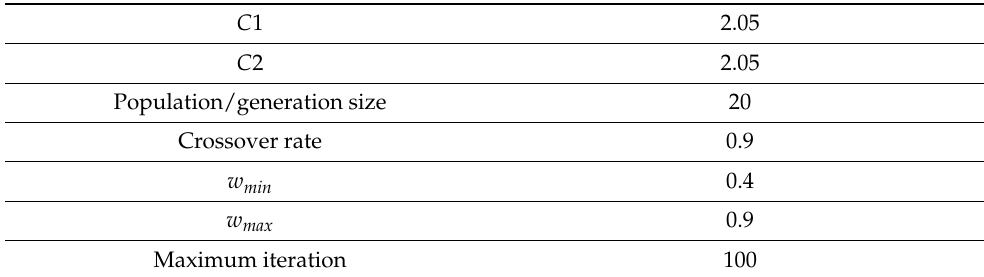
Table 5. Parameters setting for PSO and GA. C